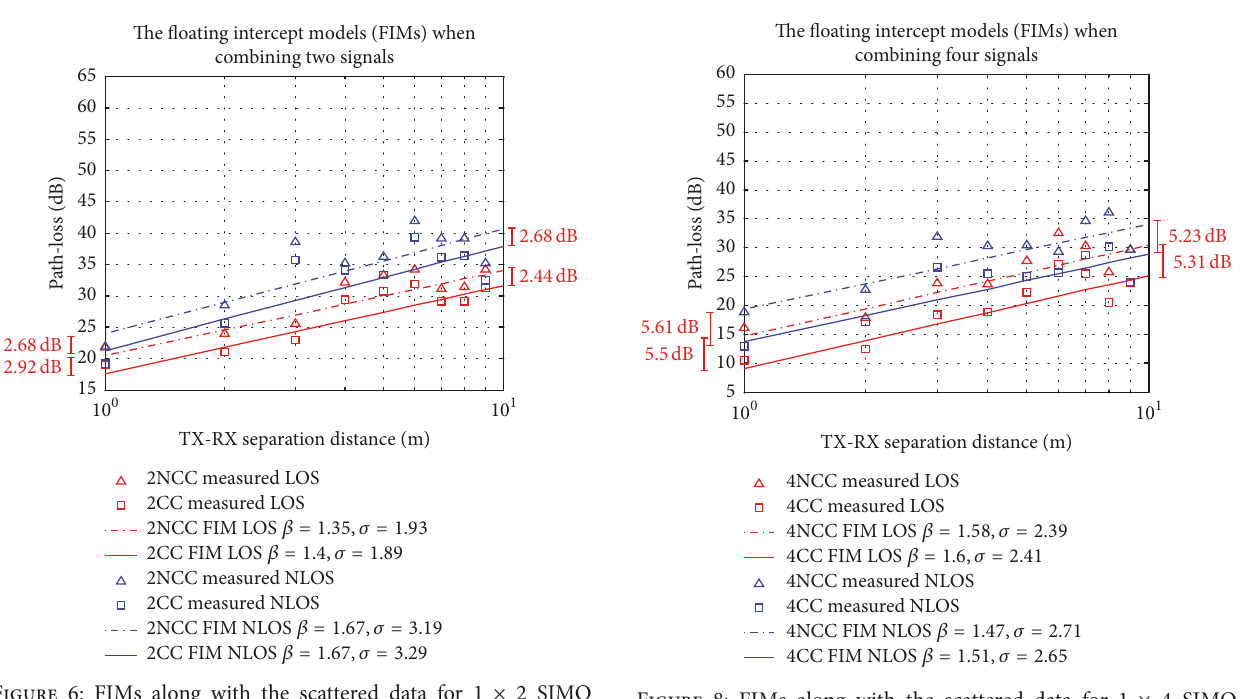
Figure 8: FIMs along with the scattered data for 1 × 4 SIMO case when considering CC and NCC for both the LOS and NLOS propagation scenarios.